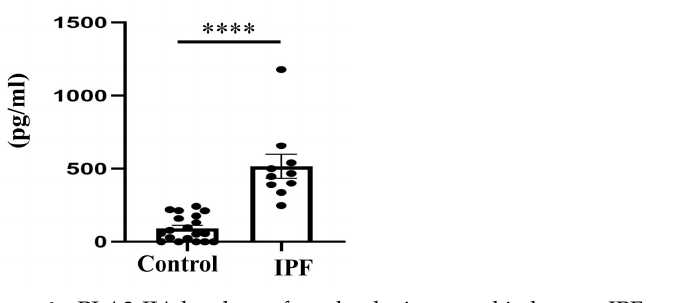
Figure 6. sPLA2-IIA levels are found to be increased in human IPF patients. ELISA that measures sPLA2-IIA in human sera of both IPF patients and healthy controls. (Values are expressed in means ± SEM, **** p value = 0.0001).